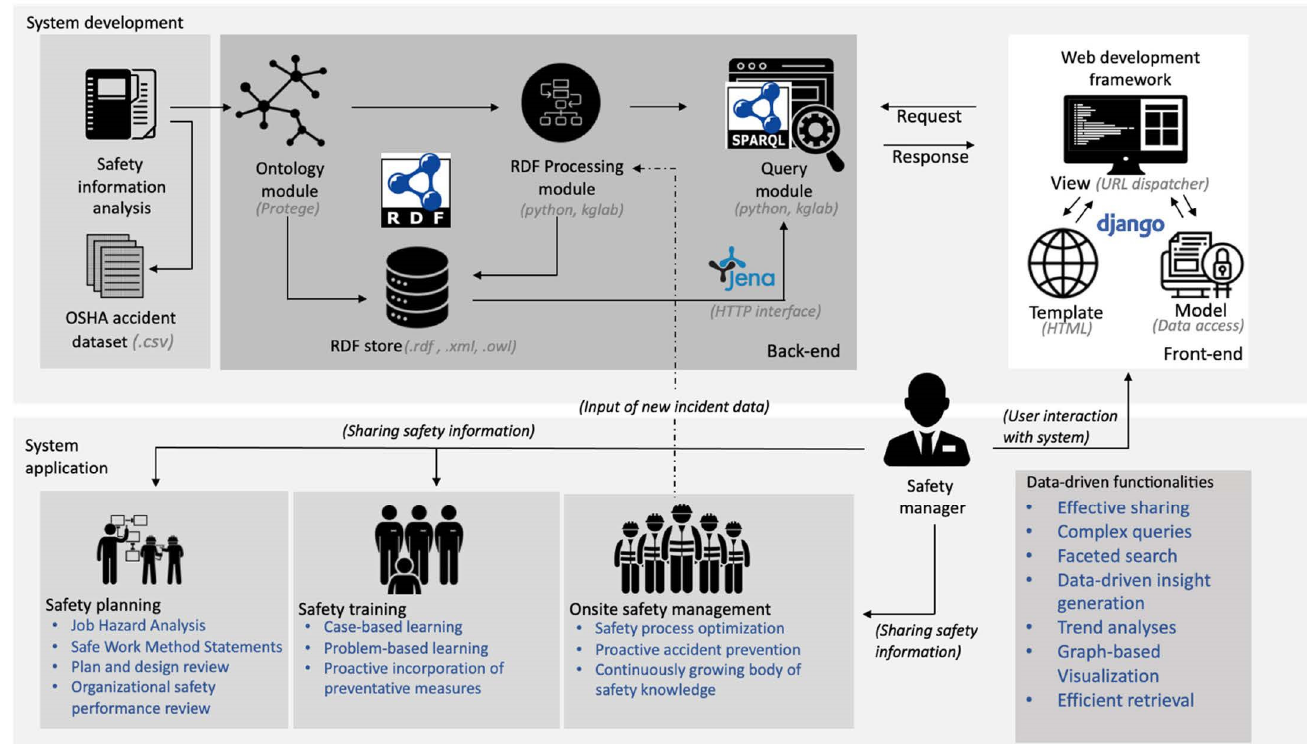
Figure 2. Development and application framework for construction safety information sharing sys- tem.